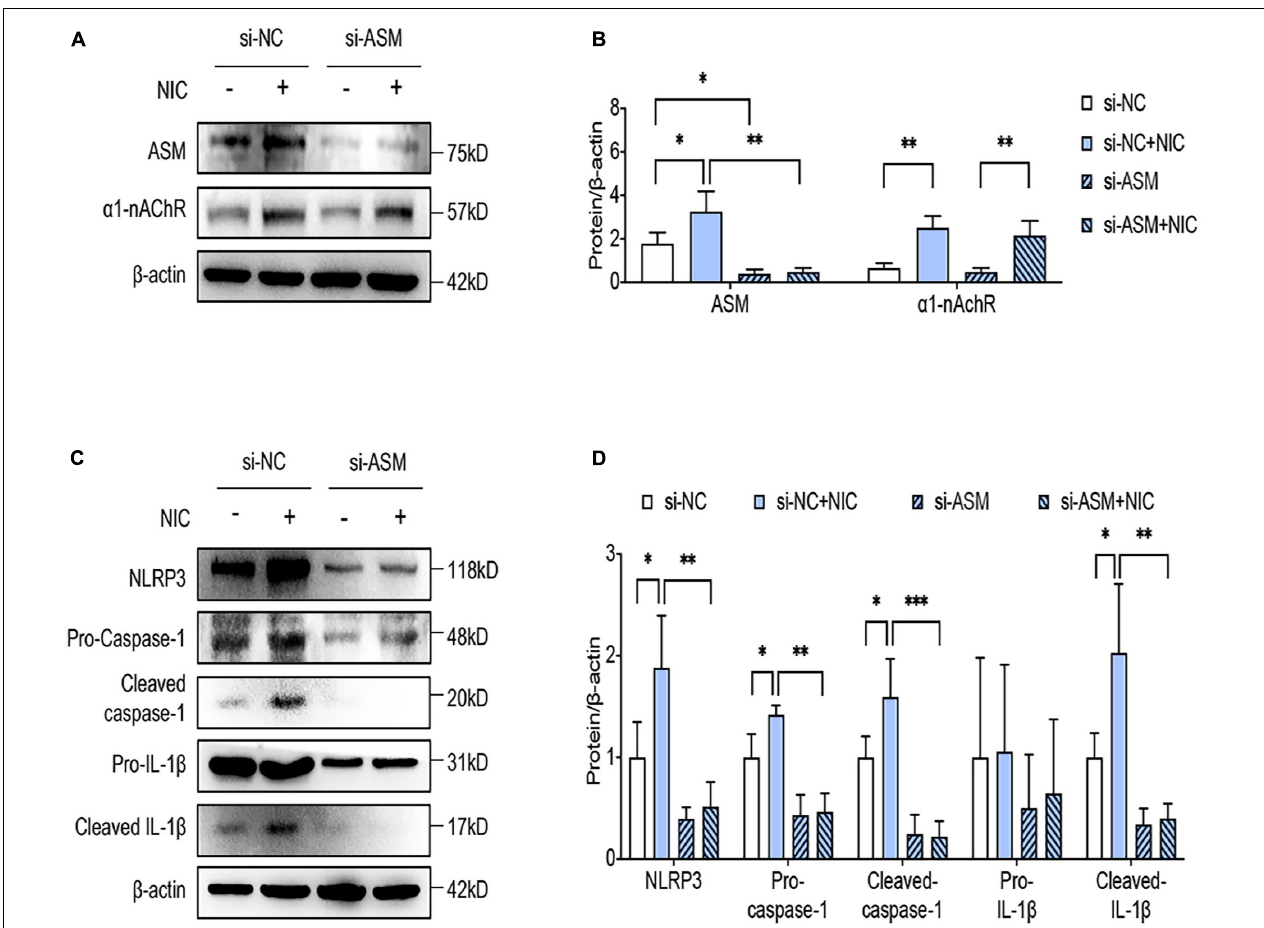
FIGURE 3 | Silencing of ASM blocked nicotine-induced NLRP3 inflammasome activation in macrophage. (A,B) The protein expression and quantitative analysis of ASM and a1-nAchR in macrophage. (C,D) The protein expression and quantitative analysis of NLRP3, pro- and cleaved caspase-1 and IL-1 β in macrophage. All data are represented as mean ± SD of three independent experiments. ANOVA test followed by Holm–Šídák post-hoc test was used for statistical analysis. ∗ p < 0.05, ∗∗ p < 0.01, ∗∗∗ p < 0.001. NLRP3, Nod-like receptor protein 3; NIC, nicotine; NLRP3, Nod-like receptor protein 3; ASM, acid sphingomyelinase; si-NC, small interfering RNA of negative control; si-ASM, small interfering RNA of ASM.